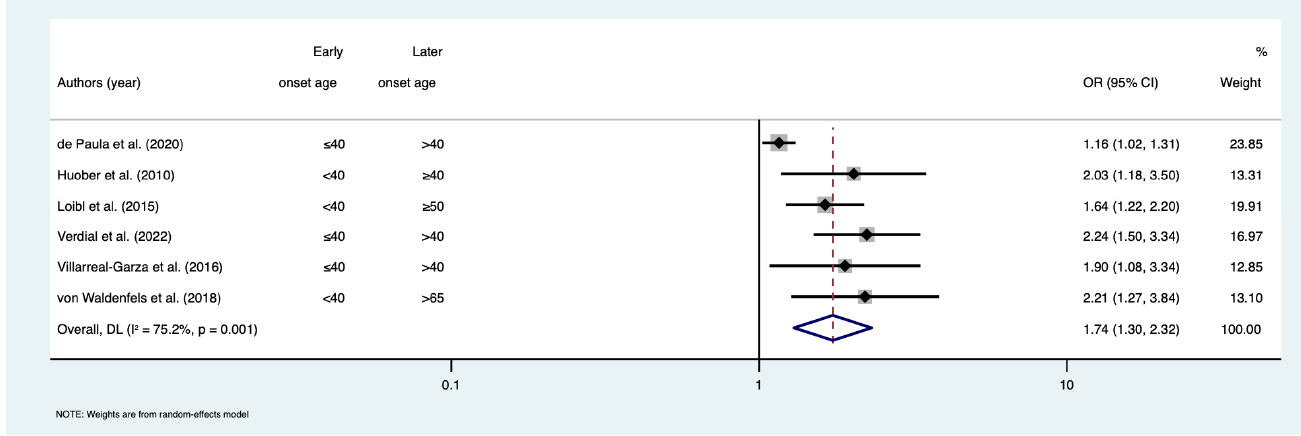
Figure 5. Forest plot for meta-analysis of overall survival. Hazard ratios less than 1 show favoura- ble outcomes in early-onset age group; hazard ratios greater than 1 show poorer outcomes in early-onset age group. References [18,20,22,28,32,34,37,39–41,44–48]. Abbreviations: CI = confi- dence interval; HR = hazard ratio.